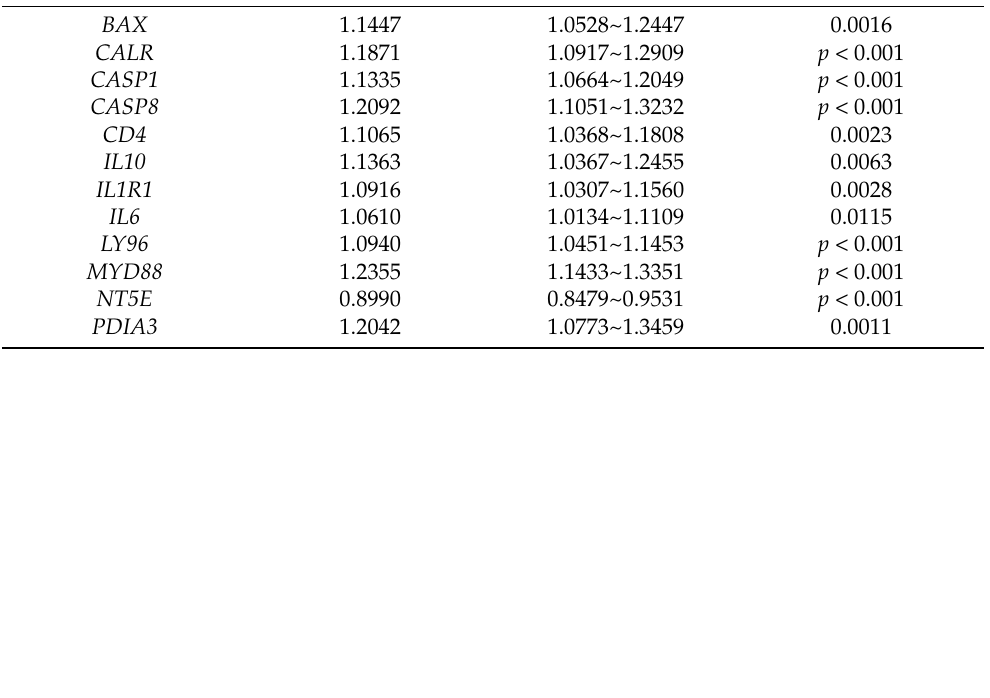
Table 1. Multivariate Cox analyses of 12 ICD-related genes correlated to prognosis in glioma patients. Id HR 95%CI p